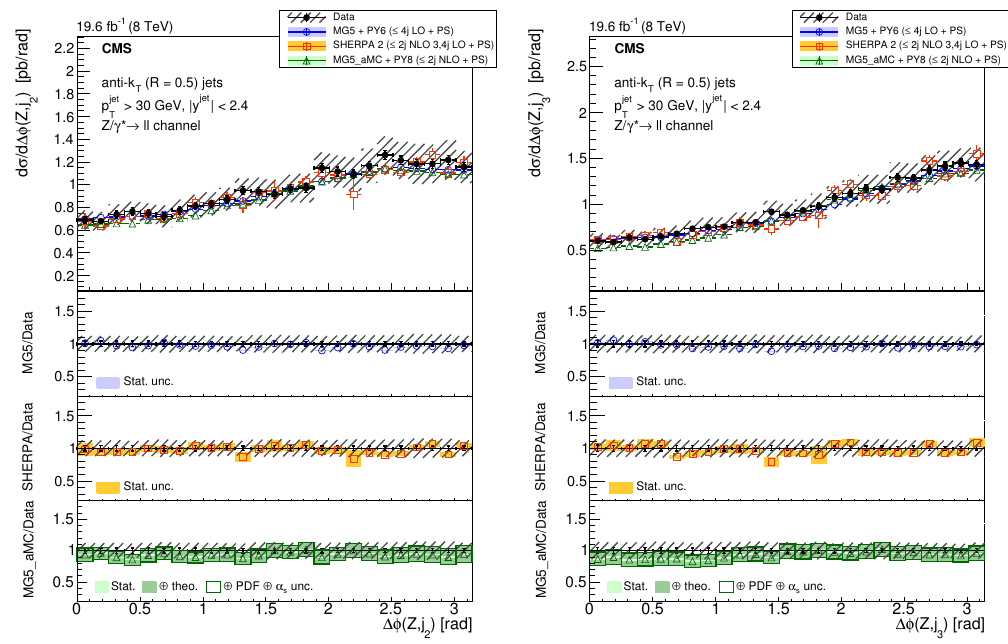
Figure 19 . The di(cid:11)erential cross section for Z ( ! ‘‘ ) + jets production for N jets (cid:21) 3 as a function of the azimuthal angle between (left) the Z boson and the second leading jet, (right) the Z boson and the third leading jet. The lower panels show the ratios of the theoretical predictions to the measurements. Error bars around the experimental points show the statistical uncertainty, while the cross-hatched bands indicate the statistical and systematic uncertainties added in quadrature. The boxes around the mg5 a mc + pythia 8 to measurement ratio represent the uncertainty on the prediction, including statistical, theoretical (from scale variations), and PDF uncertainties. The dark green area represents the statistical and theoretical uncertainties only, while the light green area represents the statistical uncertainty